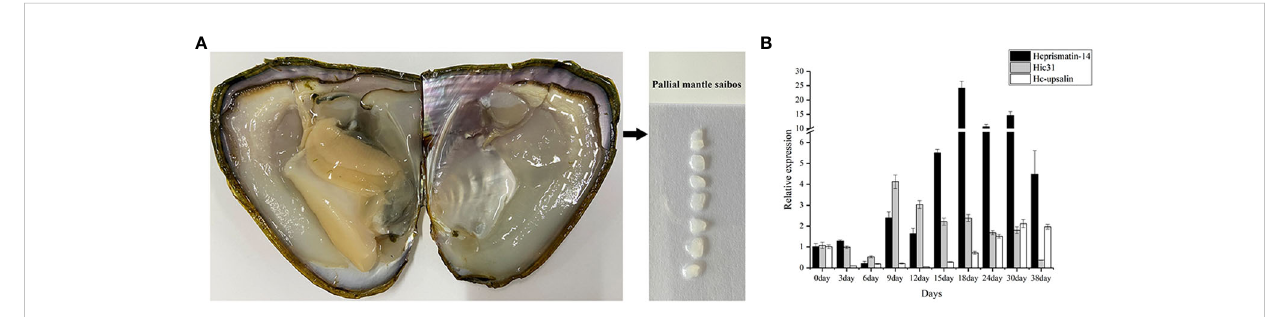
FIGURE 4 qRT-PCR analysis of Hcprismatin-14 gene expression in pearl culture assay. (A) The schematic diagram of saibos; (B) Expression analysis of Hcprismatin-14 in pearl sac during pearl